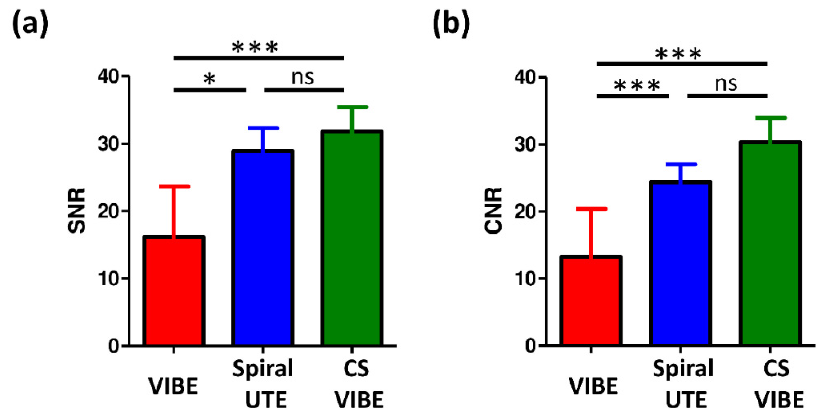
Figure 2. Comparison of ( a ) signal-to-noise ratio and ( b ) contrast-to-noise ratio in the quantitative assessment of nodule intensities between conventional VIBE, spiral UTE, or CS-VIBE sequences in lung MRI. Data are presented as means and standard deviations. Abbreviations: MRI: magnetic resonance imaging; CS: compressed sensing; VIBE: volumetric interpolated breath-hold examination; UTE: ultrashort echo time; SNR: signal-to-noise ratio; CNR: contrast-to-noise ratio; ns: not significant. * p < 0.05 and *** p < 0.001.